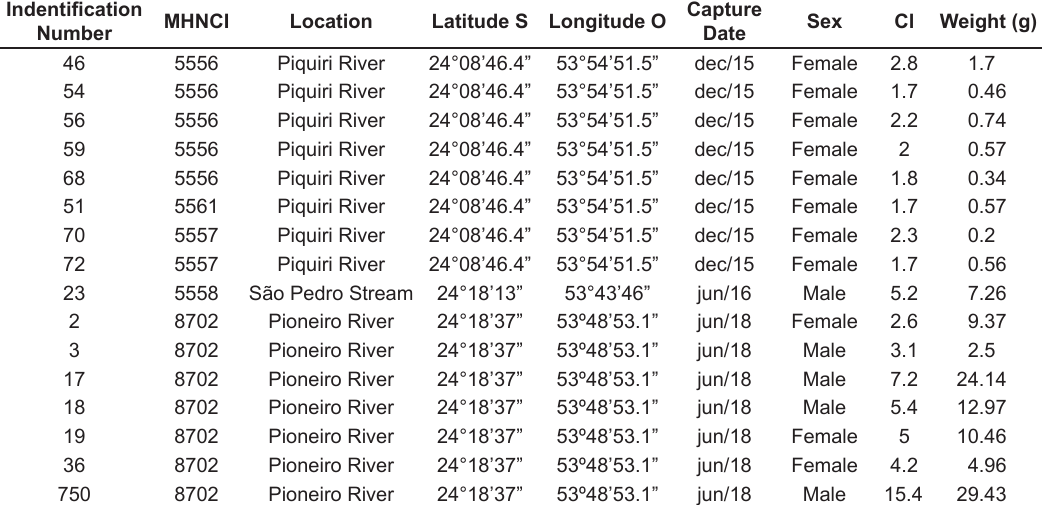
Figure 2. (a) Captured female specimen of Malaysian prawn Macrobrachium rosenbergii ; (b) Detailing of the long and upwardly curved rostrum; (c) Detailing of the telson reaching far beyond the longer posterior Table 1. Identification number, deposit record at the Capão da Imbuia Natural History Museum (MHNCI), location, capture date, sex, carapace length (Cl), and weight in grams of Malaysian prawn Macrobrachium rosenbergii specimens.